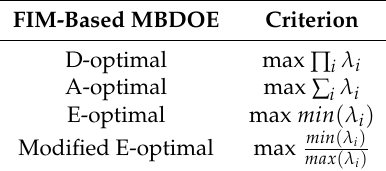
Table 1. Model-based designs of experiments (MBDOEs) using the Fisher information matrix